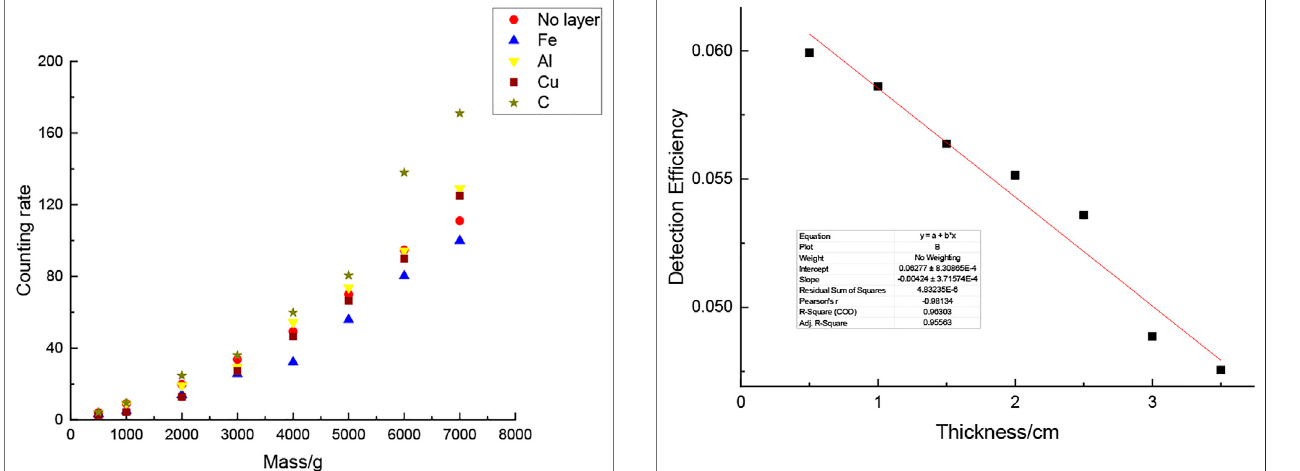
FIGURE 12 | Fitting result of the